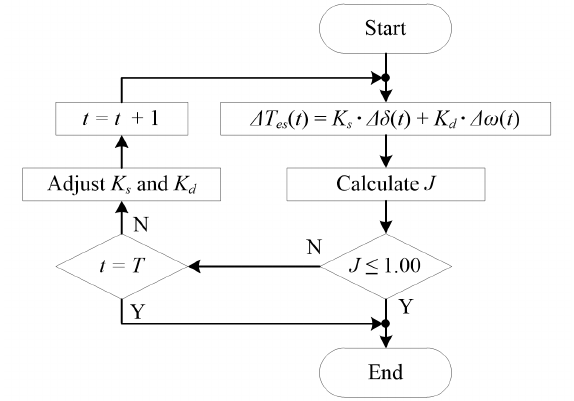
Figure 6. Flowchart for the estimation process of K s and K d .